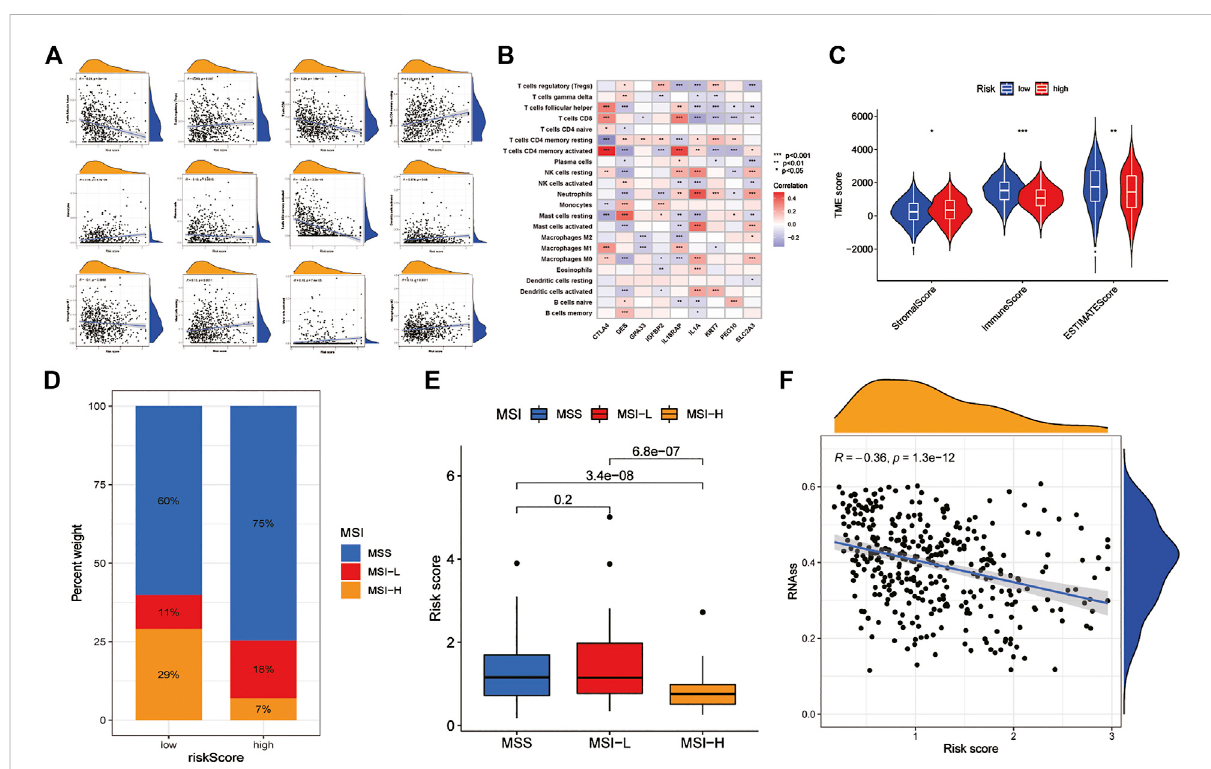
FIGURE 7 Analysis of TME characteristics between the high- and low-risk groups (A) Correlation between immune cells and RS (B) Correlations between the abundance of immune cells and 9 DEGs (C) Differences in the StromalScore and ImmuneScore between the high- and low-risk groups (D,E) Relationships between RS and MSI (F) Correlation of RS with CSC. TME: tumour microenvironment. MSI: microsatellite instability. CSC: cancer stem